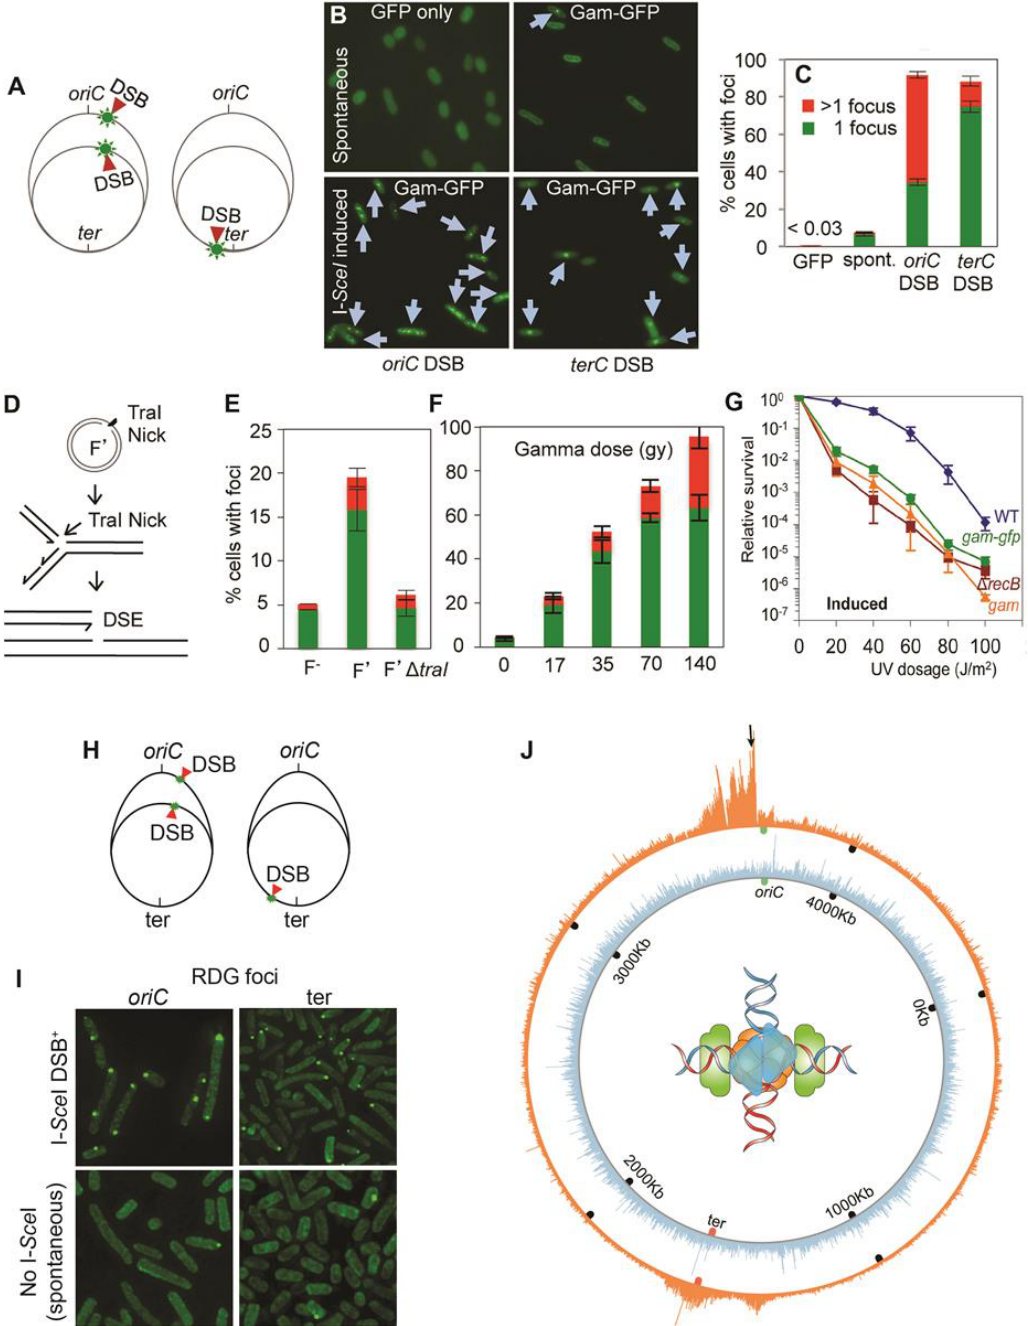
FIGURE 14: GamGFP and RDG quantify DSBs and HJs, map HJ footprints by ChIP-seq in living cells. (A-G) GamGFP foci quantify double-strand breaks (DSBs) in living cells and trap DSB ends causing DNA-repair deficiency. Data from [250]. (A) Strategy for E. coli chromosome cleavage with chromosomally encoded I- Sce I ds endonuclease at engineered cut sites (red arrows). (B) Representative images of GamGFP foci without I- Sce I cleavage (spontaneous, top row) and after I- Sce I cleavage at sites either prox- imal to the replication origin (left column), or distal to the replication origin (right column). In replicating E. coli cells, there are more copies of the origin-proximal DNA than the origin-distal sequences, and more DSBs generated, and more GamGFP foci, with origin-proximal than -distal cleavage. (C) Numbers of GamGFP foci correspond with expected numbers of I- Sce I-generated DSBs. Quantification of GamGFP focus data from multiple experiments diagrammed in parts A and B of this figure. (D) GamGFP recognizes one-ended DSBs generated by replication-fork collapse at an enzymatically-generated single-strand nick, made by the TraI single-strand endonuclease at its recognition sequence in a F’ single -copy conjugative plasmid. (E) Quantification of one-ended DSBs generated by replication-fork collapse at the TraI-generated single- strand nick in the F’ single -copy conjugative plasmid. F- , no plasmid. ∆ traI , no TraI nuclease. (F) Linear dose response of GamGFP foci with gamma irradiation. With these data and the known number of DSBs per Gray of gamma in E. coli , we estimated the efficiency of GamGFP labeling of DSBs to be about 70% (30% of DSBs are not seen as foci). (G) GamGFP production blocks DSB repair, causing a sensitivity to ultraviolet (UV) light similar to that of DNA-repair- defective ∆ recB null-mutant cells. (H-J) RDG foci represent HJs in living cells and RDG ChIP-seq maps HJ footprints. Data from [260]. (H) Strategy for E. coli chromosome cleavage with chromosomally encoded I-Sce I endonuclease at engineered cut sites (red arrows, DSB) (I) Representative images of RDG foci after I- SceI cleavage (top row) or spontaneous foci (bottom row), with cleav- age near the replication origin ( oriC ) or terminus (ter). (J) HJ ChIP-seq at repairing DSBs shows directionality of DSB repair. The orange wheel shows the circular chromo- some of E. coli bacteria. The spikes indicate where a molecular intermediate in DNA repair — four-way DNA junctions — accumulate near a reparable DSB in the genome (black downward arrow), and also at and after the replication terminus in the chromosome replication path. Blue, RDG ChIP-seq map of an uncleaved E. coli chromosome showing sites of spontaneous HJs. Center: diagram of HJ bound by RuvC (blue) assisted by E. coli RuvB (green) which stabilizes RuvC on